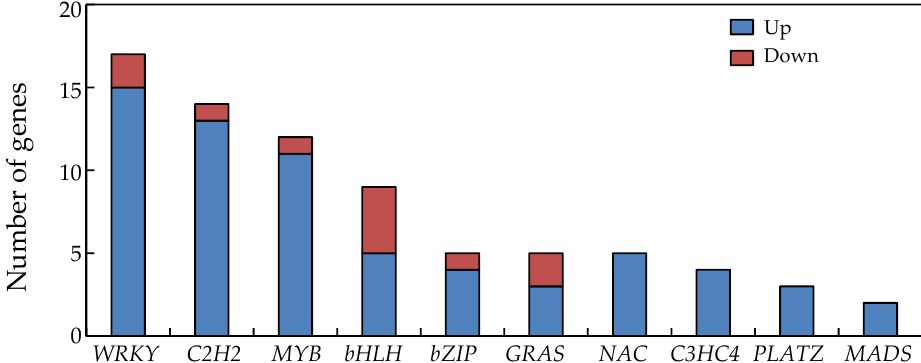
Figure 5. Differentially expressed genes associated with transcription factor activity in soybean 381 nodules. 382